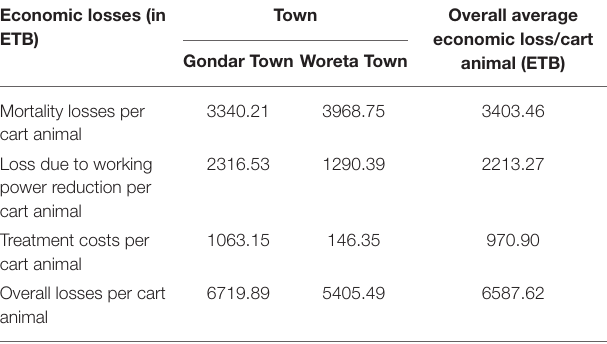
TABLE 5 | Animal level average economic losses of epizootic lymphangitis by